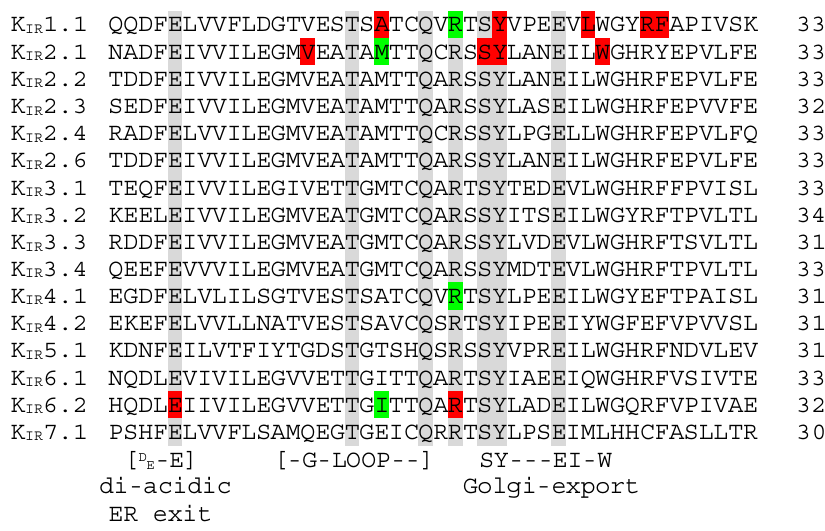
Figure 4. K IR 1–7 sequence alignment of the C-terminal mutation hotspot. Red: Mutations associated with aberrant trafficking; Green: Residues whose mutations are currently not related to impaired trafficking. Numbers at the right refer to the last amino-acid residue in the respective sequence shown. Conserved residues among all K IR members are shaded gray. Locations of the di-acidic ER exit, G-loop and the Golgi-Export signal sequence (see text) are indicated below the alignment.